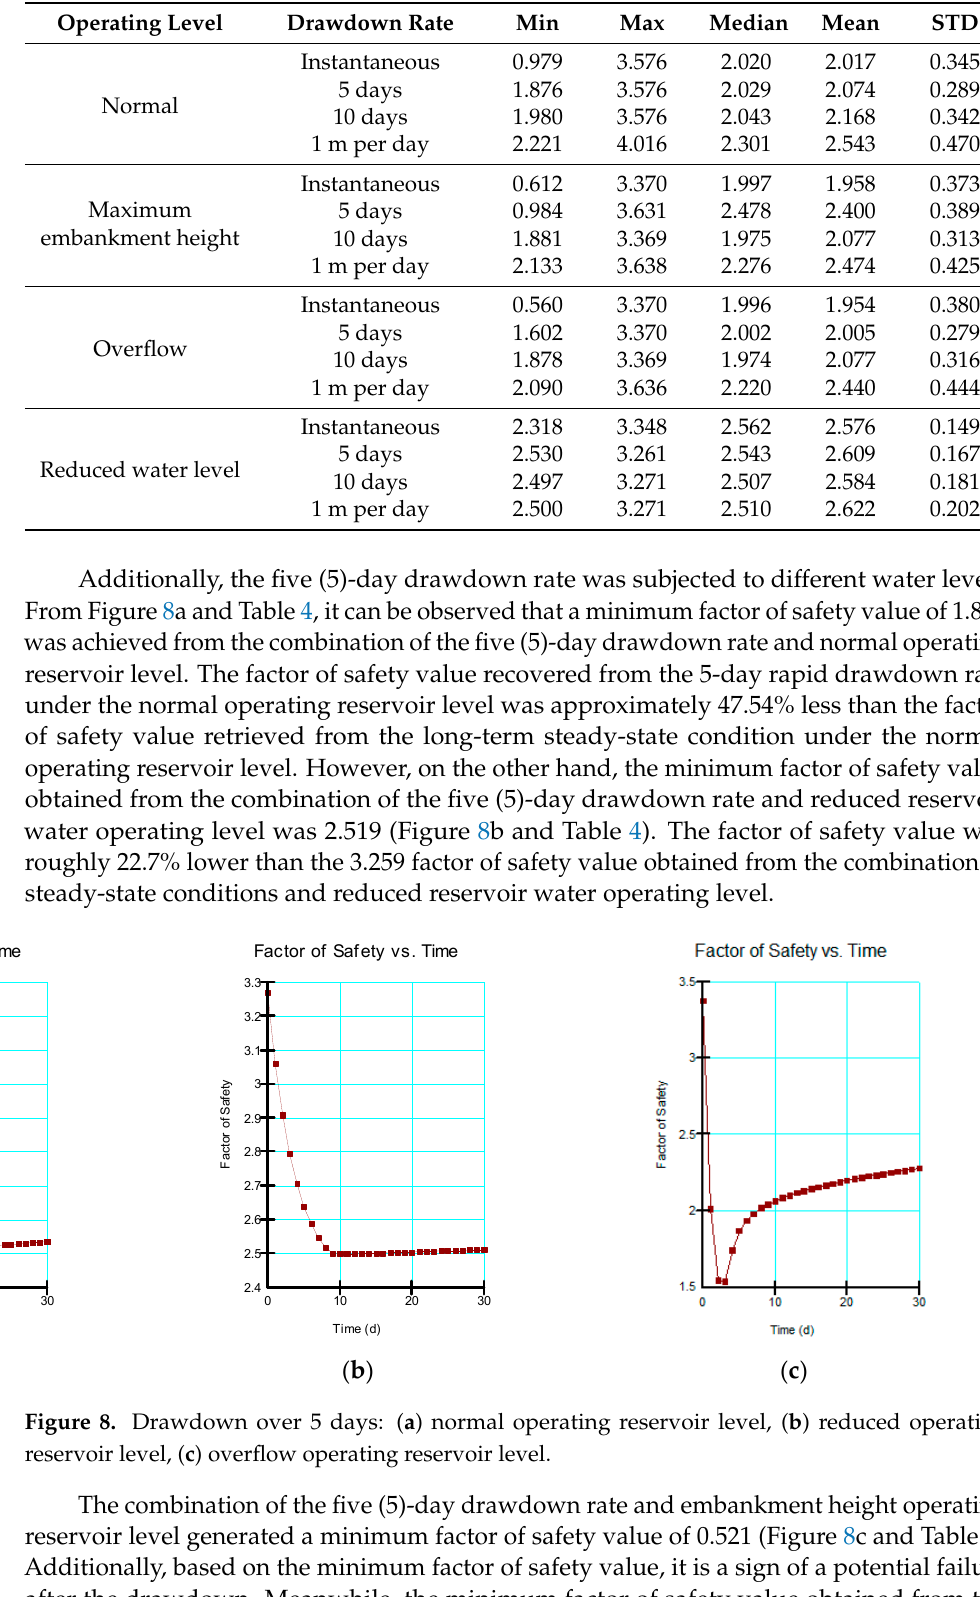
Table 4. Summary of the factor of safety values retrieved from different cases.